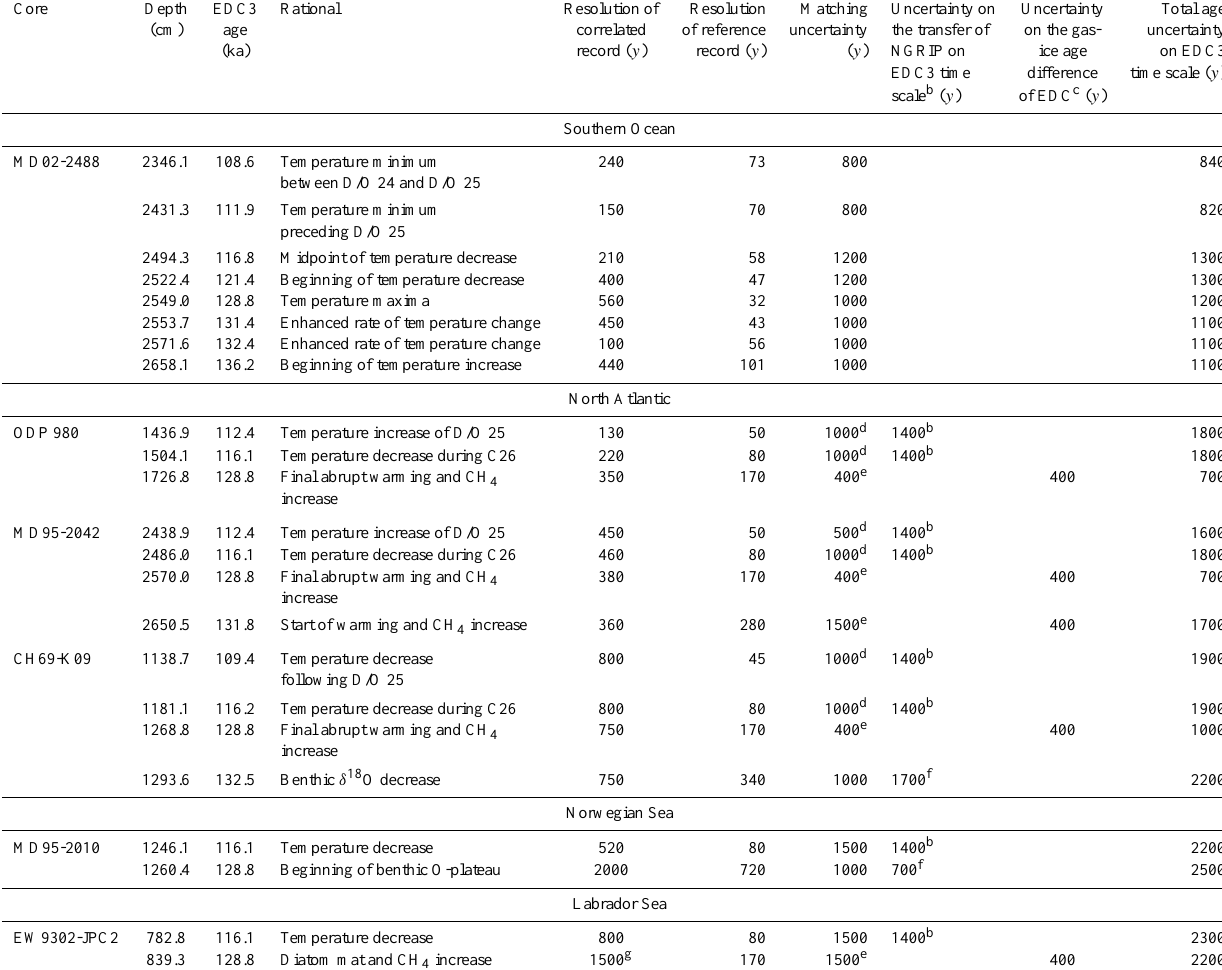
Table 4. Tie-points defined in each sediment core and relative age uncertainties (1 σ , in years) on the EDC3 time scale. The total age uncertainty (last column of the table) is derived from the quadratic sum of individual uncertainties a